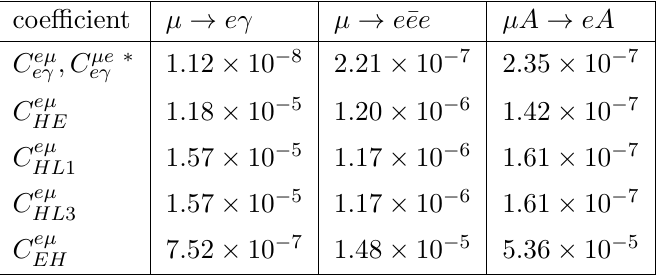
= c W C eµ − s W C eµ . eγ EB EW